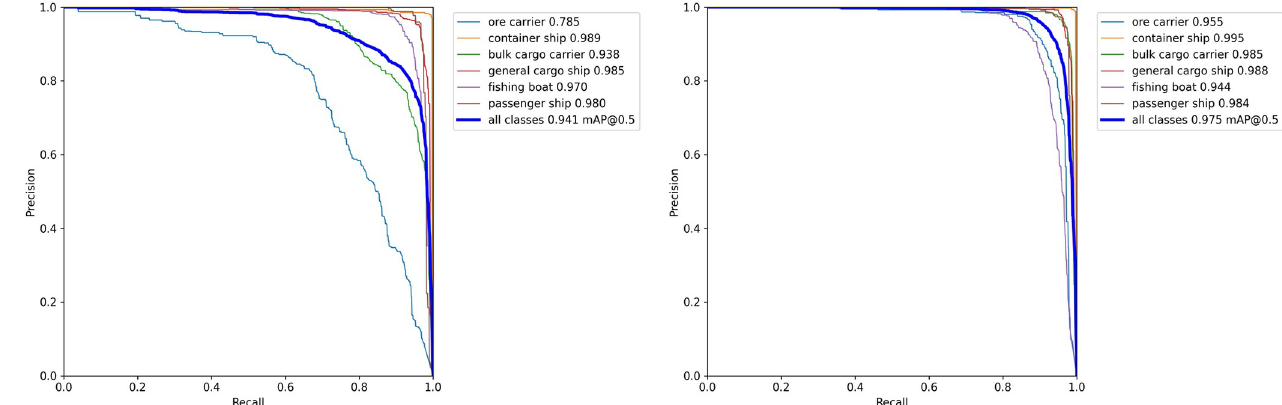
Fig 13. P-R curves for different types of ships. (a) YOLOv5s model P-R curves (b) MC-YOLOv5s model P-R curves.